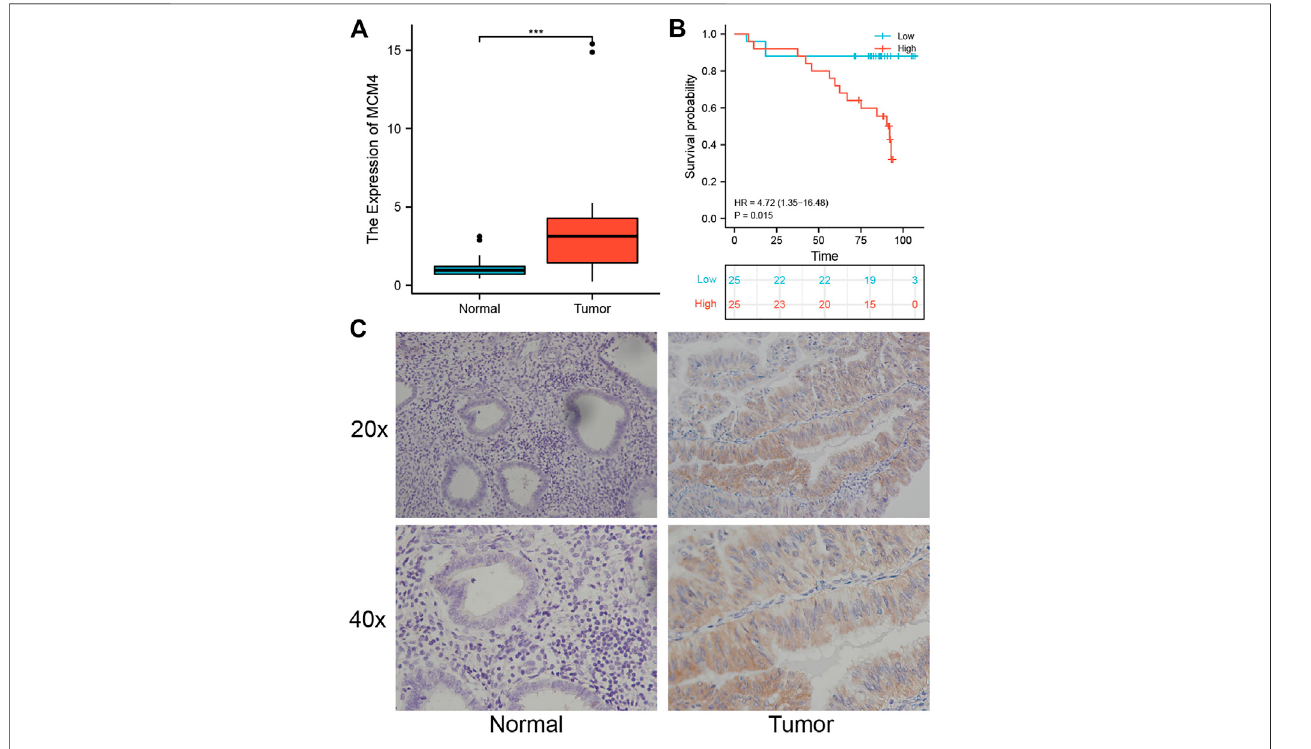
FIGURE 7 | Expression and prognosis of MCM4 in human UCEC tissues. (A) Expression level of MCM4 in UCEC. MCM4 was signi fi cantly upregulated in human UCEC tissues compared with normal tissues. (B) Kaplan-Meier curves showed high expression of MCH4 was associated with poor OS in human UCEC tissues. (C) Immunohistochemical (IHC) staining of MCM4 expression (20× and 40×). UCEC, Uterine corpus endometrial carcinoma. OS, overall survival.